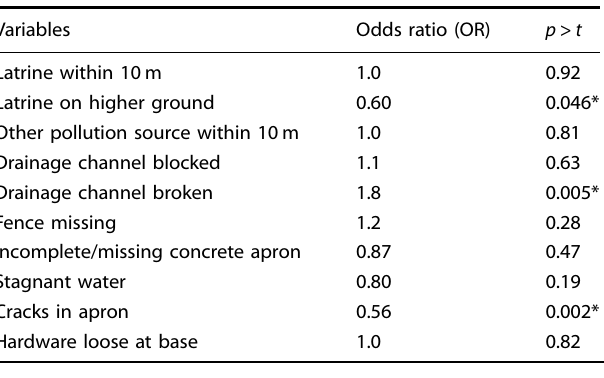
Table 2. Results of logistic regression assessment of individual sanitary risk factors — sanitary risk factors with * are signi fi cantly associated with E. coli presence/absence at the 95% con fi dence level.